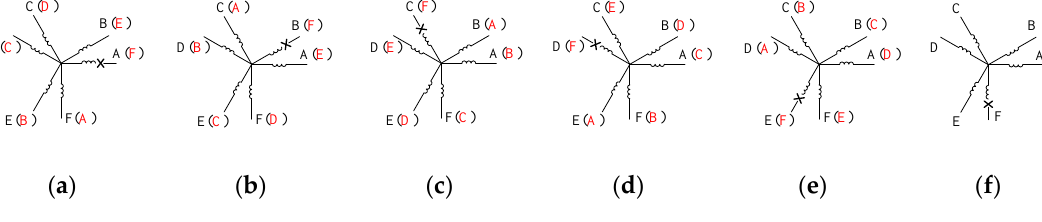
Figure 3. Winding terminal remarking. ( a ) A-phase failure; ( b ) B-phase failure; ( c ) C-phase failure; ( d ) D-phase failure; ( e ) E-phase failure; ( f ) F-phase failure.